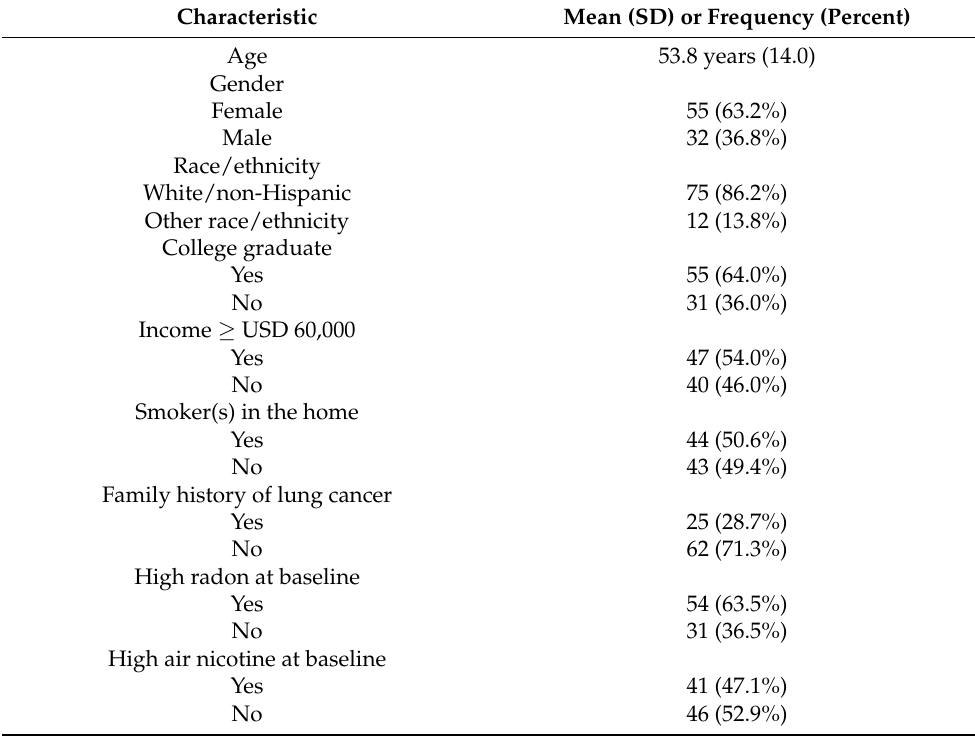
Table 1. Demographic and personal characteristics ( N =